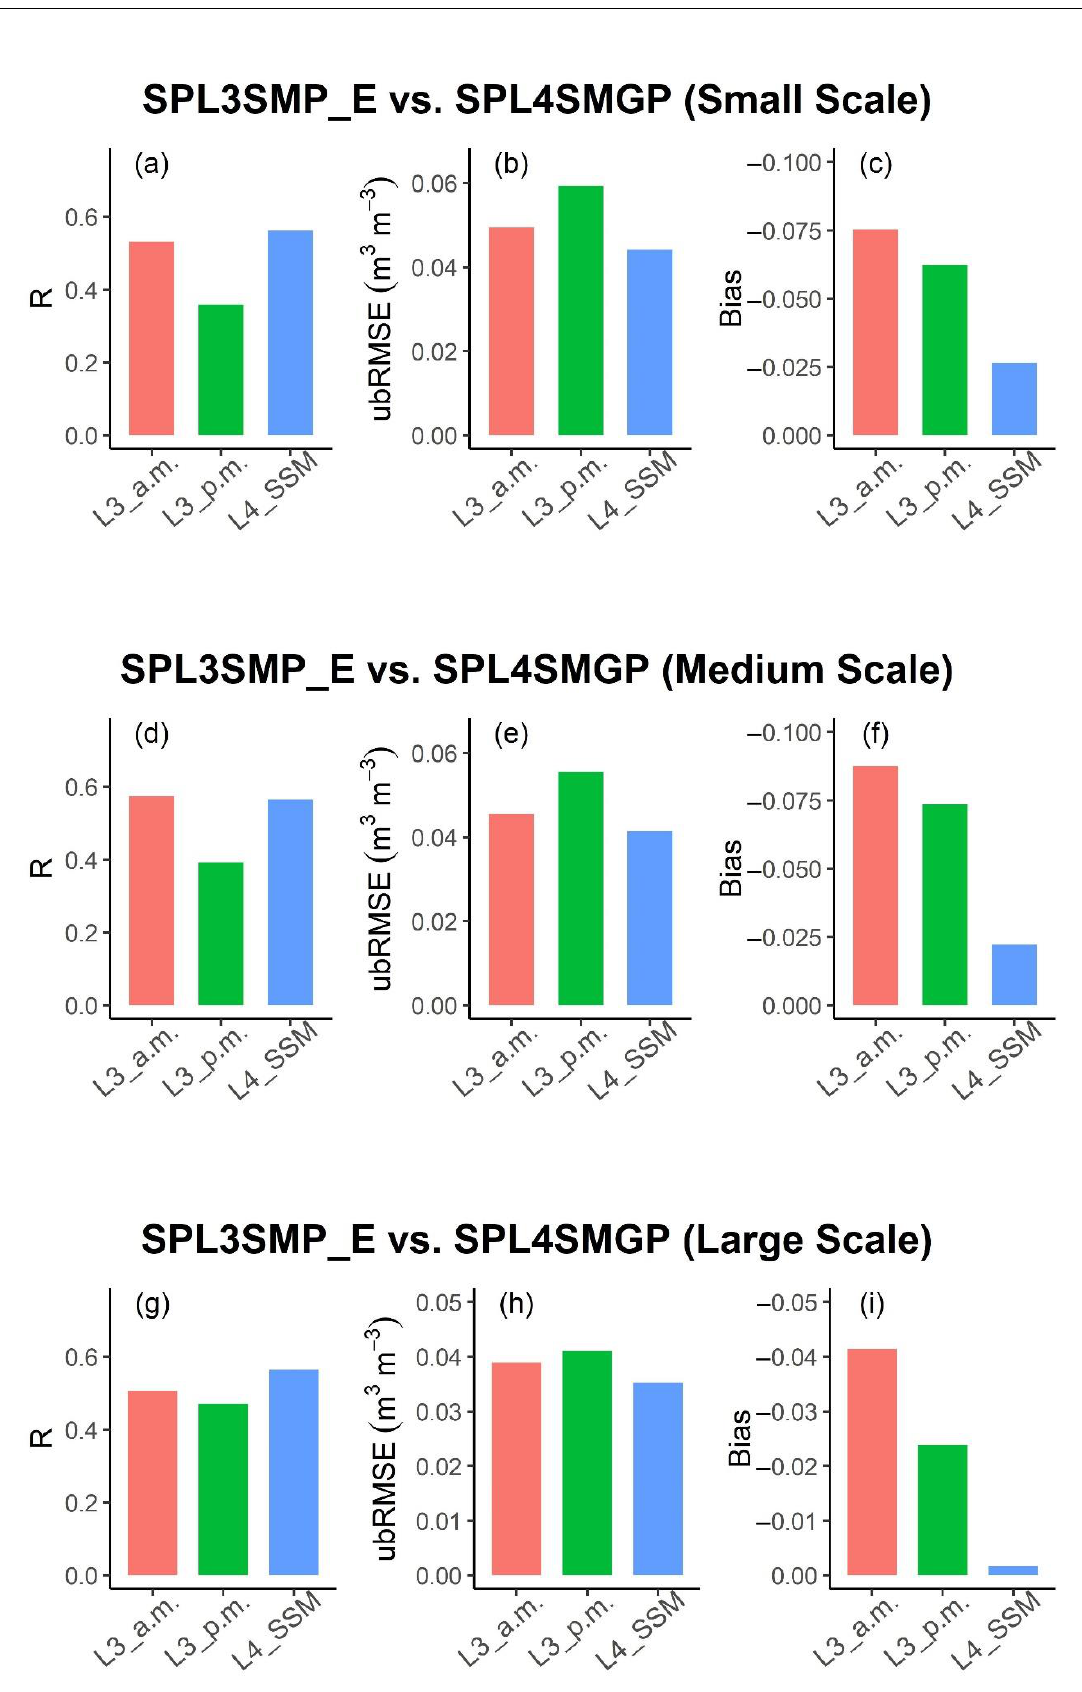
Figure 11. Comparison of evaluation metrics (R ( a , d , g ), ubRMSE ( b , e , h ), and bias ( c , f , i )) for SPL3SMP_E (a.m. and p.m.) and SPL4SMGP SSM estimates for S-scale, M-scale, and L-scale